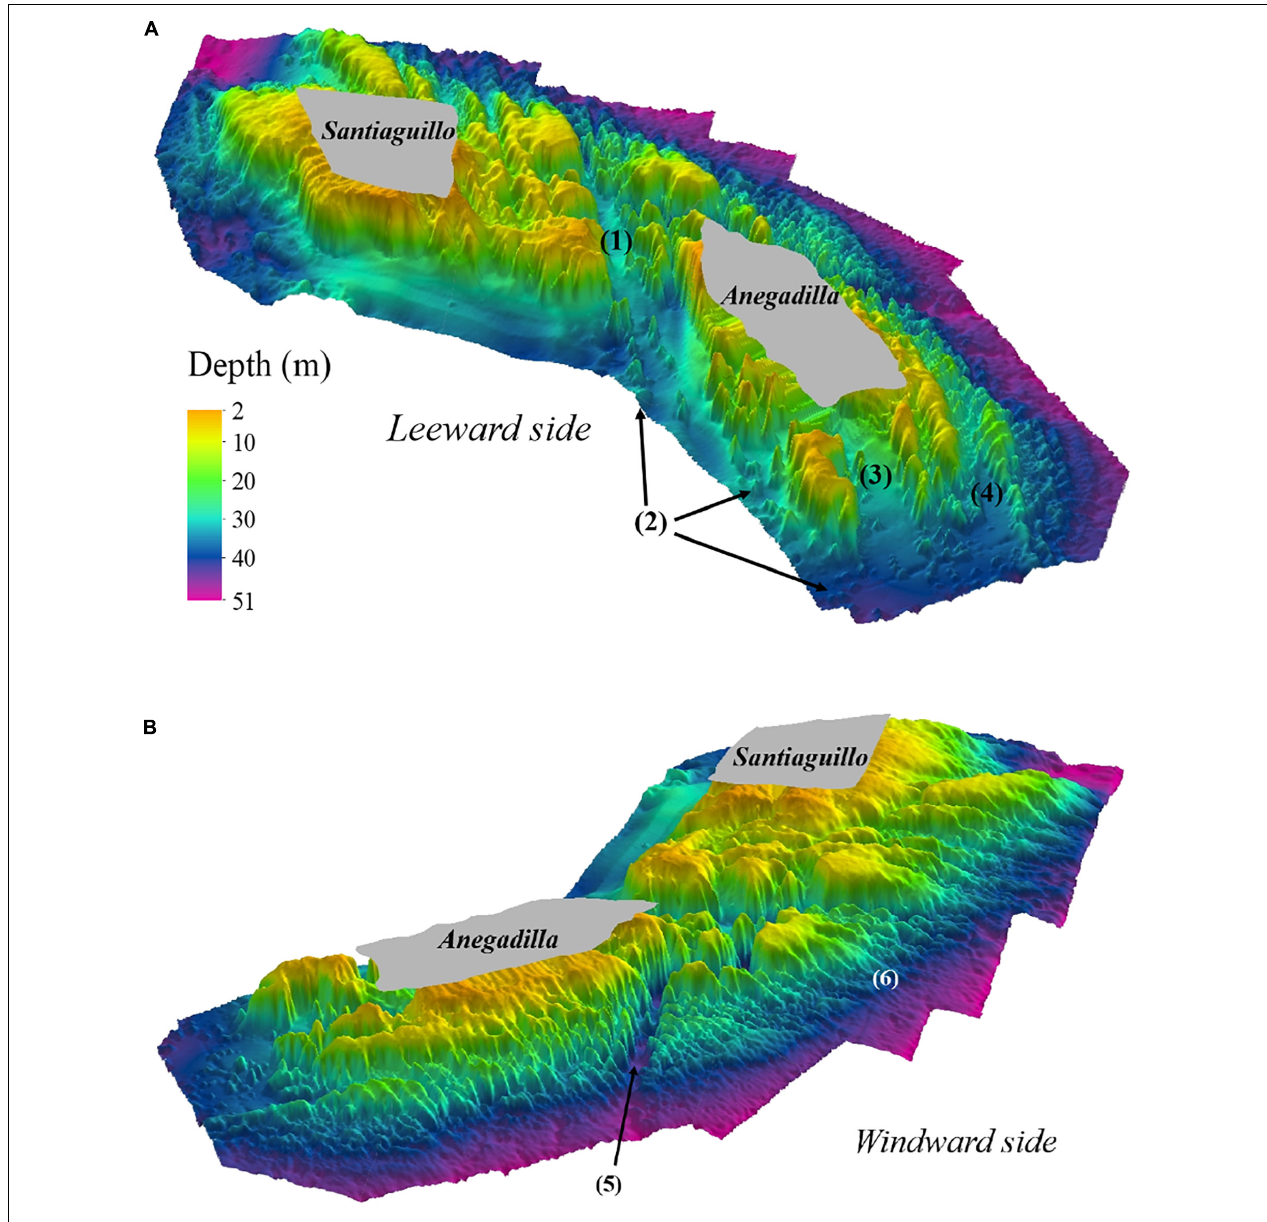
FIGURE 3 | SARC’s three-dimensional bathymetric model, showing a leeward side view (A) . Remarkable geomorphic features are shown: (1) Channel-1, (2) dispersed mounds, (3) Channel-2 and (4) Channel-3. SARCs’ three-dimensional bathymetric model, showing a windward side view (B) . Geomorphic features shown are: (5) Channel-4 and (6) spur and grooves. Shallow areas ( ≤ 2 m deep) not surveyed are shown in gray. Vertical exaggeration 8x.